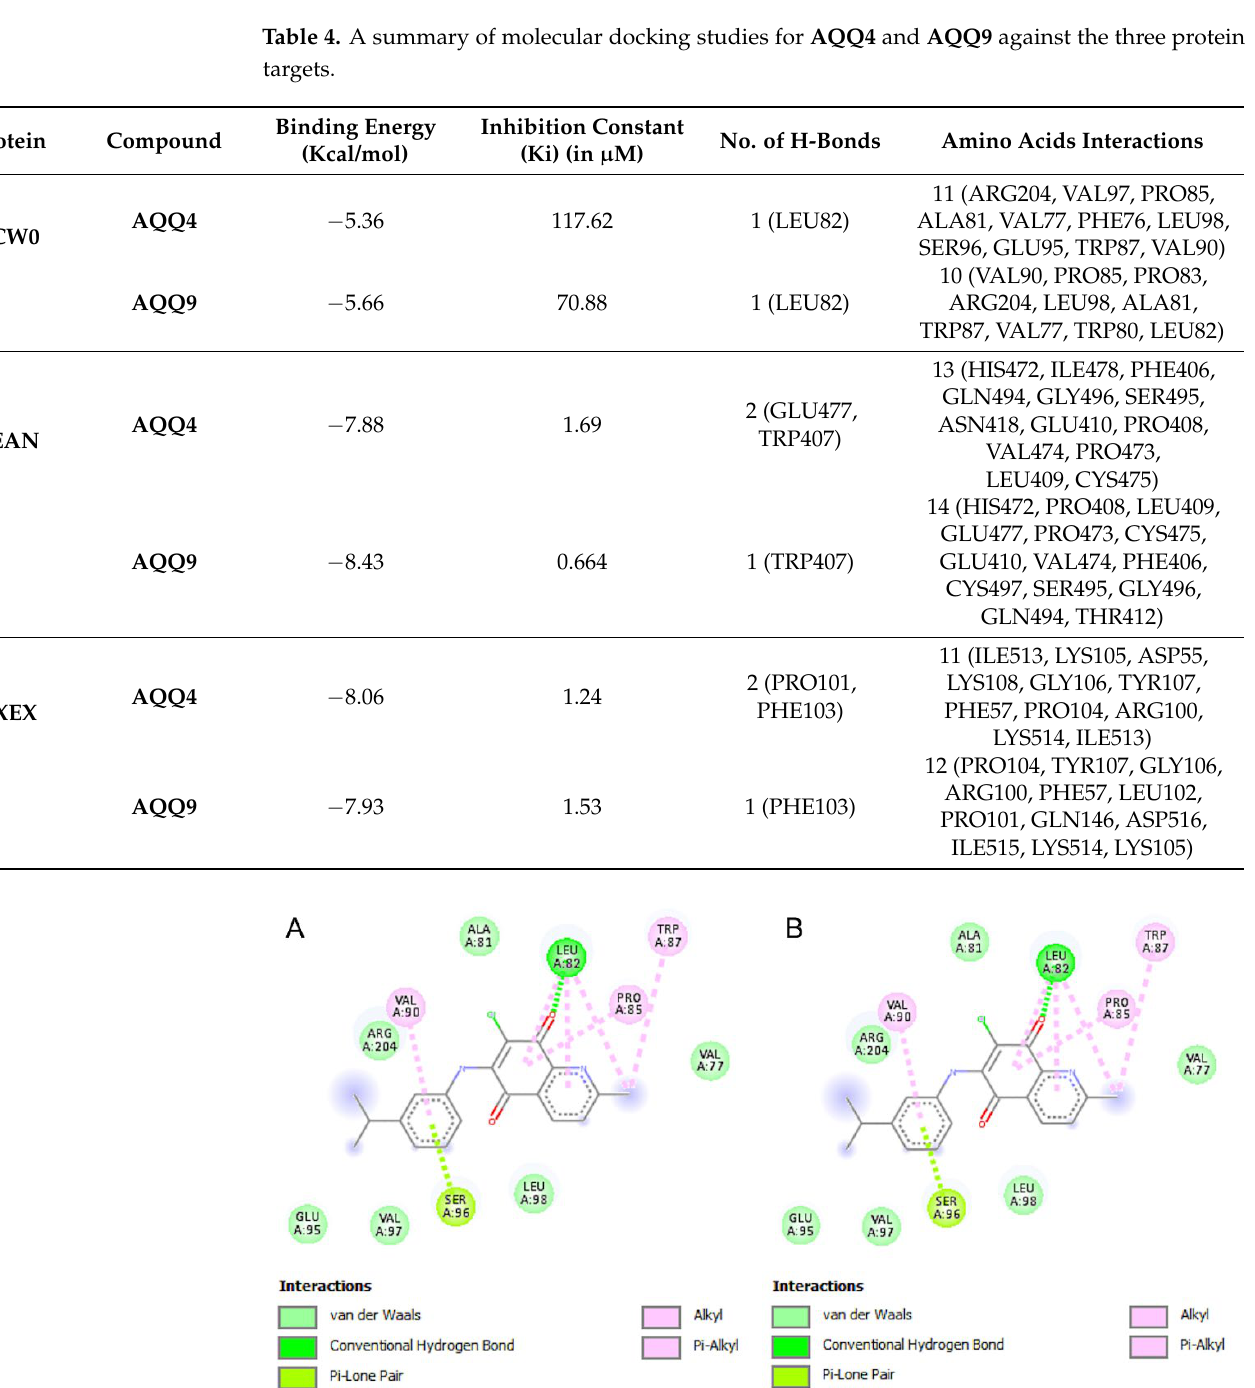
Figure 8. Schematic 2-D representation of protein–ligand interactions between the key residues of